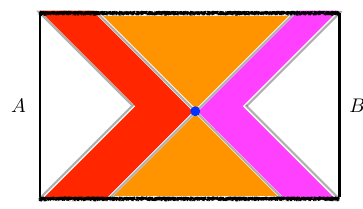
Figure 3 . A wide Penrose diagram corresponding to an entangled pure state of combined AB